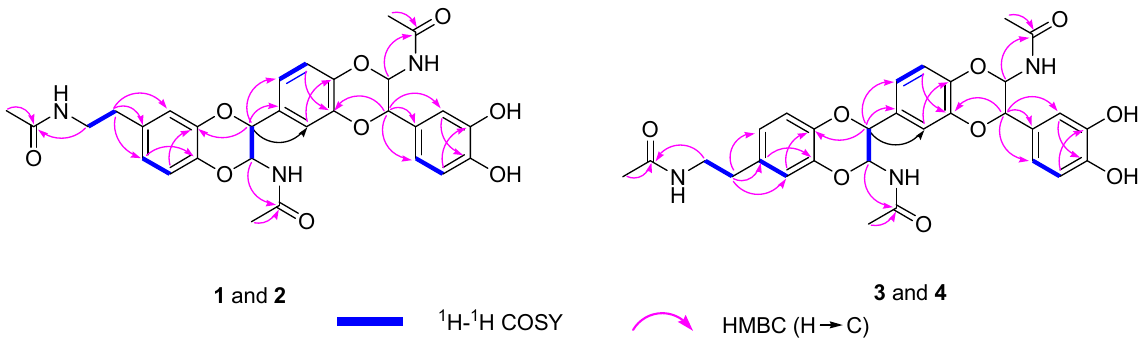
Figure 2. Key correlations of 1 H- 1 H-COSY and HMBC for compounds 1 – 4 .